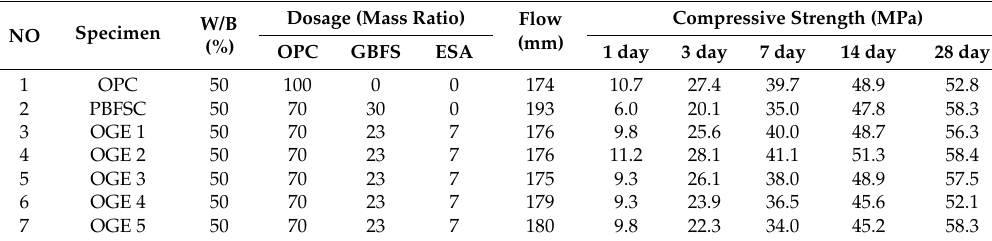
Table 5. Mix, compressive strength, and flow of mortar.